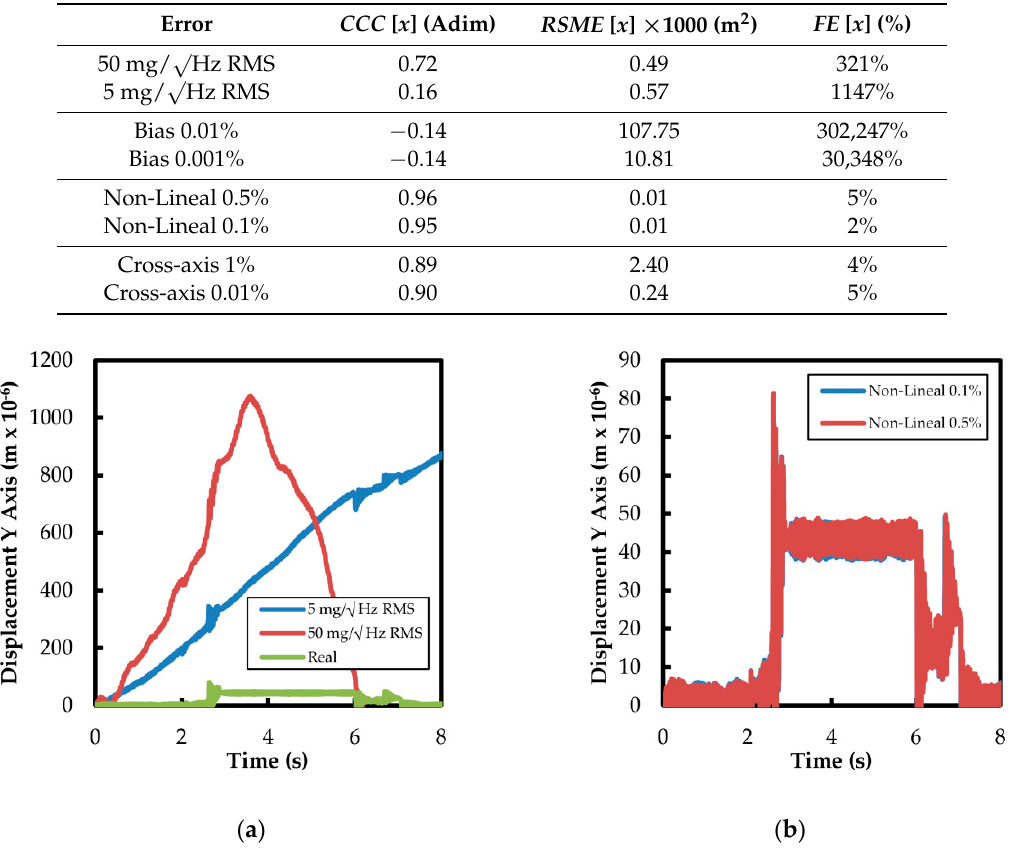
Figure 13. Calculated displacement for Y axis; ( a ) noise and ( b ) non-linearity error evaluation.